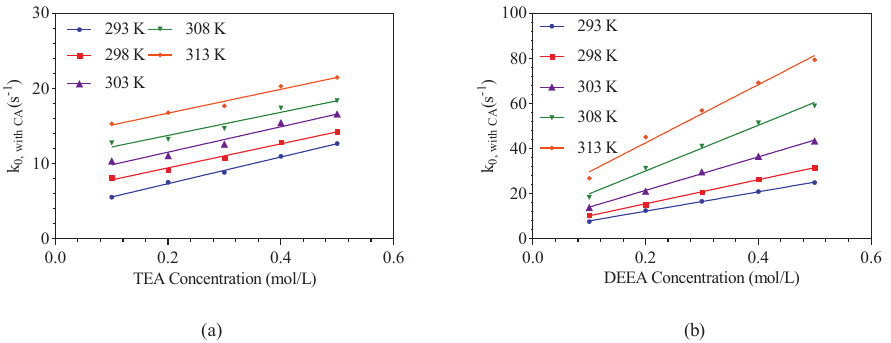
Figure 7. The k 0, with CA values of CO reacting with amine solutions under 3 g/m 3 CA in the reaction 2 system over temperature range of 293–313 K: ( a ) represents the TEA–CO the DEEA–CO –H O 2 2